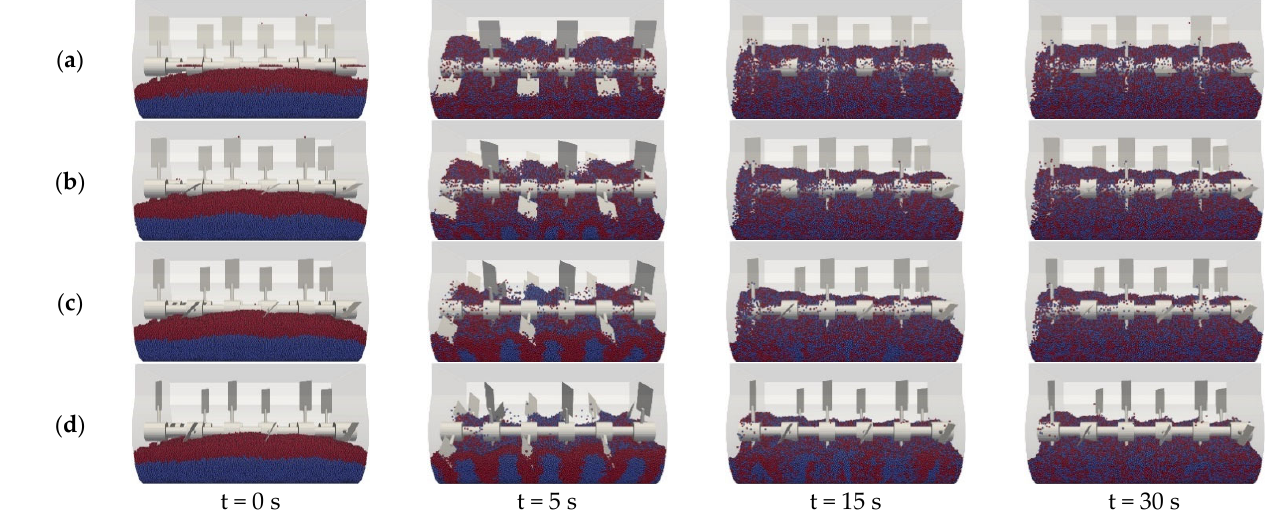
Figure 8. Mixer’s snapshot with various paddle angles at different time instants: ( a ) 0°; ( b ) 30°; ( c ) 45°; ( d ) 60°.